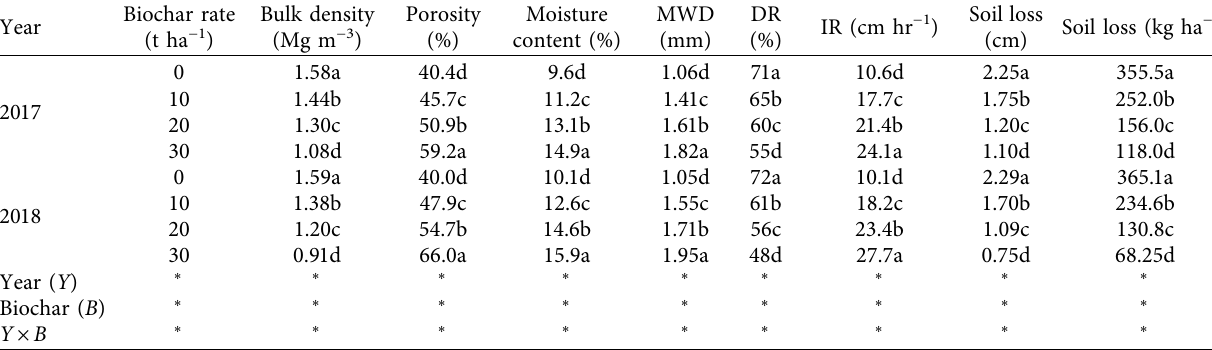
Table 2: Effect of biochar on some selected soil physical properties in 2017 and 2018.